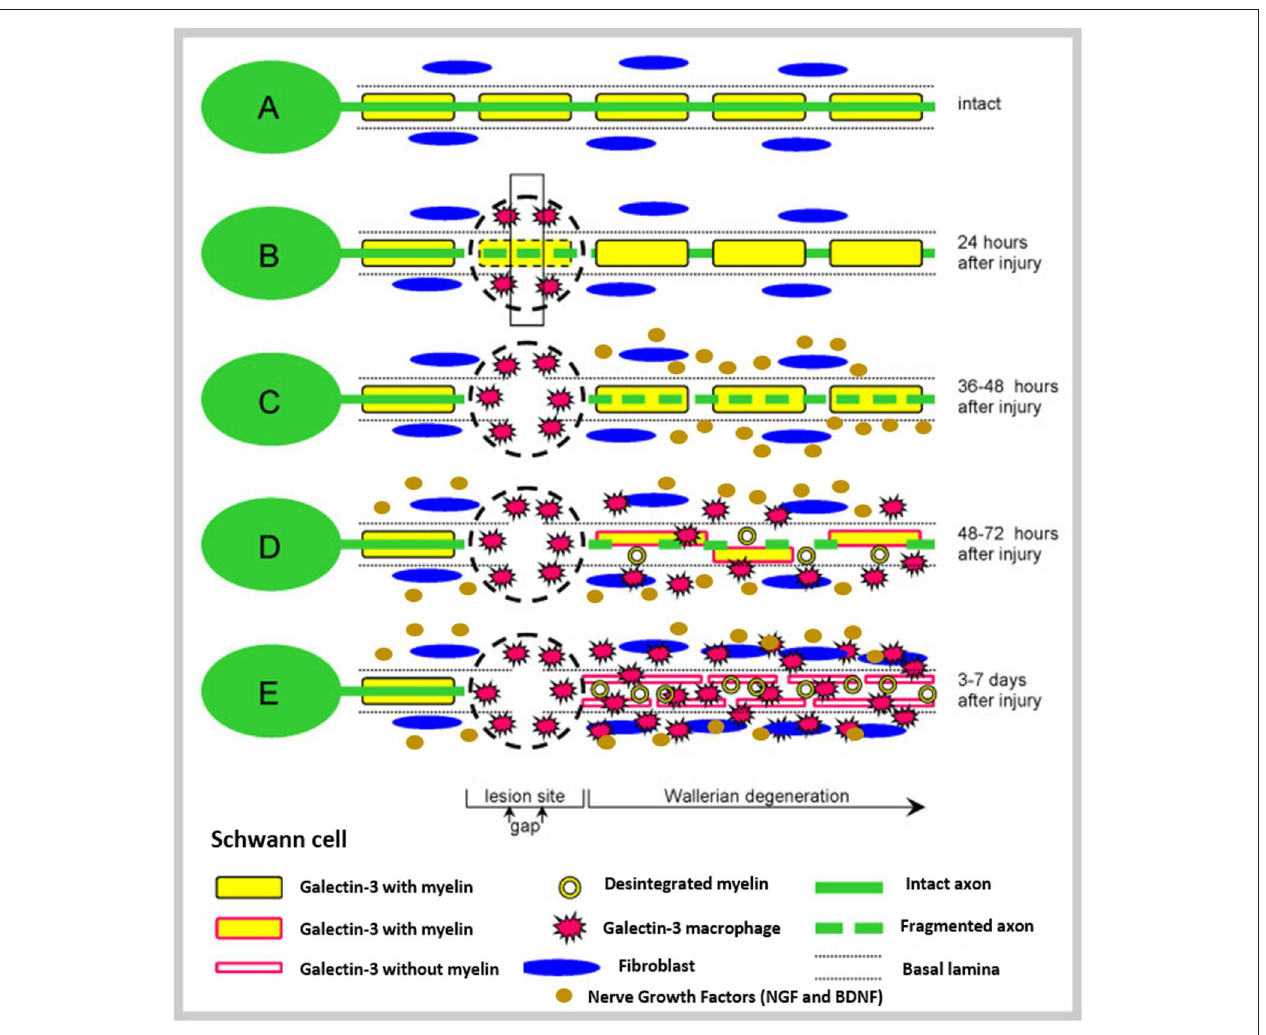
FIGURE 2 | Schematic representation of injury and regenerative process involved in peripheral nerves. (A) Represents the intact nerve, with myelin enwrapping healthy axons; (B) The moment where an injury occurs, instantaneous tissue damage happens at the injury site. After a few hours, macrophages gather at the lesion; (C) The normal Wallerian degeneration process starts roughly 1 day after the initial trauma and axons start to disintegrate; Growth factors are released by Schwann cells in the distal end. (D) Enrolment of Galectin-3 macrophages, which contribute to myelin degradation and removal of myelin debris. Growth factors are retrogradely transported to the proximal end, toward the cell body; and (E) The typical degradation of the distal nerve end happens with the participation of the Galectin-3 macrophages and Schwann cells. These cellular components scavenge deteriorated myelin and axonal matter. After the clearance of the debris, Schwann cells proliferate and align, forming the Bunger bands, for future guiding of the regenerating axons. Reproduced with the permission from Rotshenker (2011).